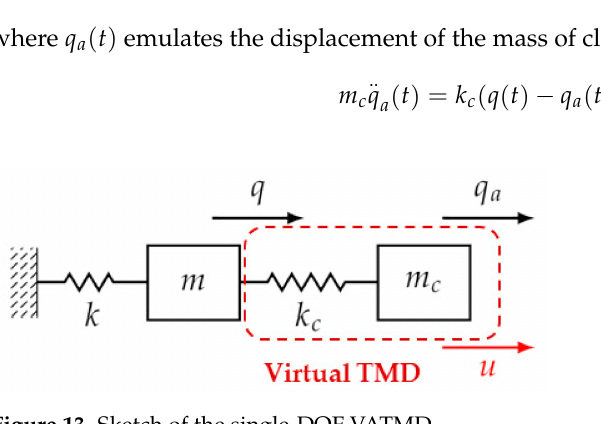
Figure 13. Sketch of the single-DOF